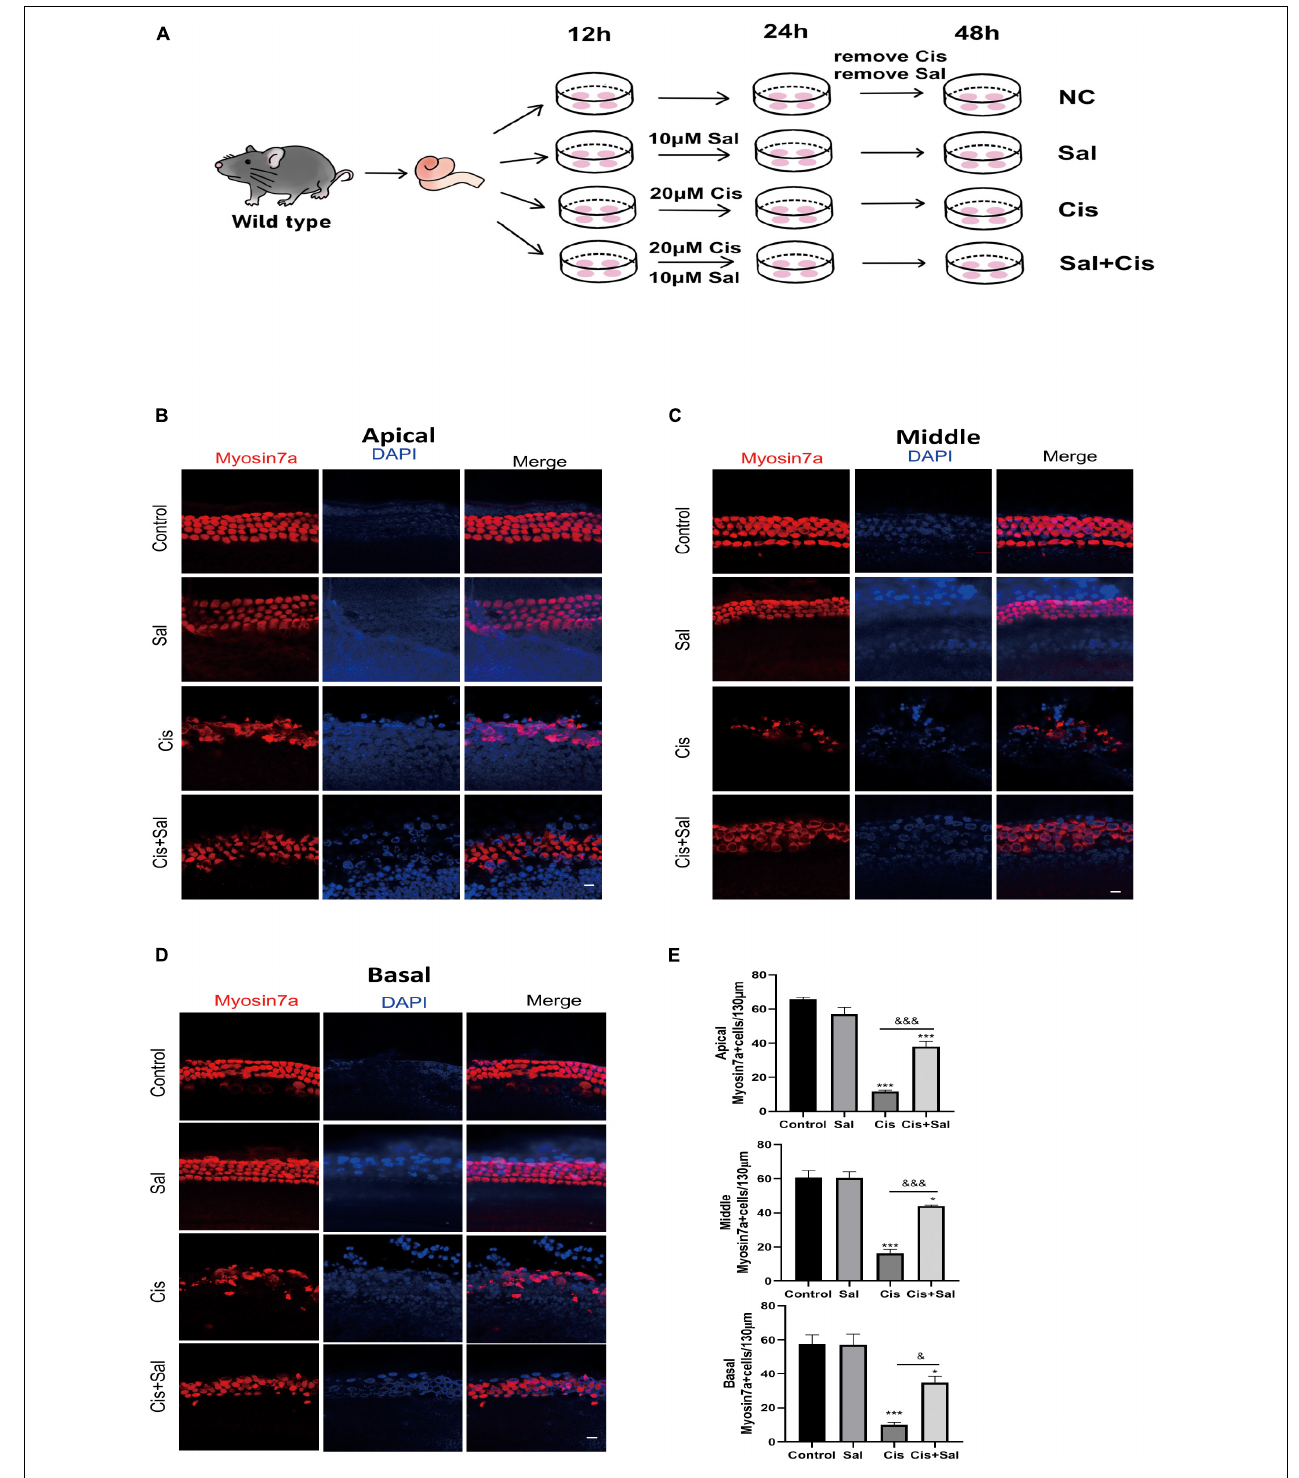
FIGURE 3 | Sal promotes hair cell (HC) survival in the cochlea after cisplatin exposure. (A) Schematic diagram of drug addiction in tissue culture. (B,D) HCs in the apical (B) , middle (C) , and basal turns (D) of the cochlea were stained with anti-myosin-VIIa antibody and DAPI in the control, 10 µ M Sal, 20 µ M cisplatin, and 20 µ M cisplatin + 10 µ M Sal groups. (E) Quantification of the number of myosin VIIa-positive cells in the apical, middle, and basal turns of the cochlea. Values are presented as mean ± SEM from independent experiments. * P < 0.05 and *** P < 0.001 vs. the control group; & P < 0.05 and &&& P < 0.001 vs. the cisplatin group. Scale bars = 10 µ